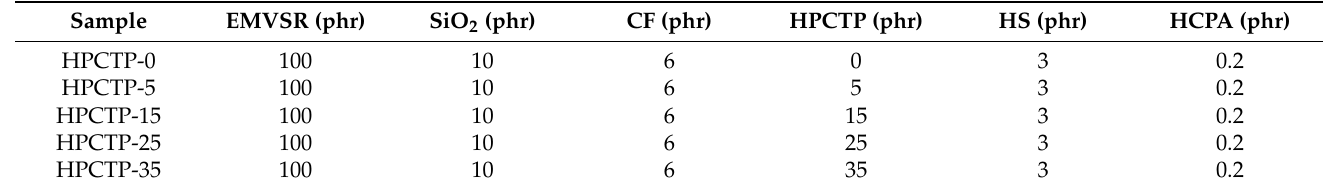
Table 2. The Formulation of HPCTP Modified EMVSR-Based Composites.